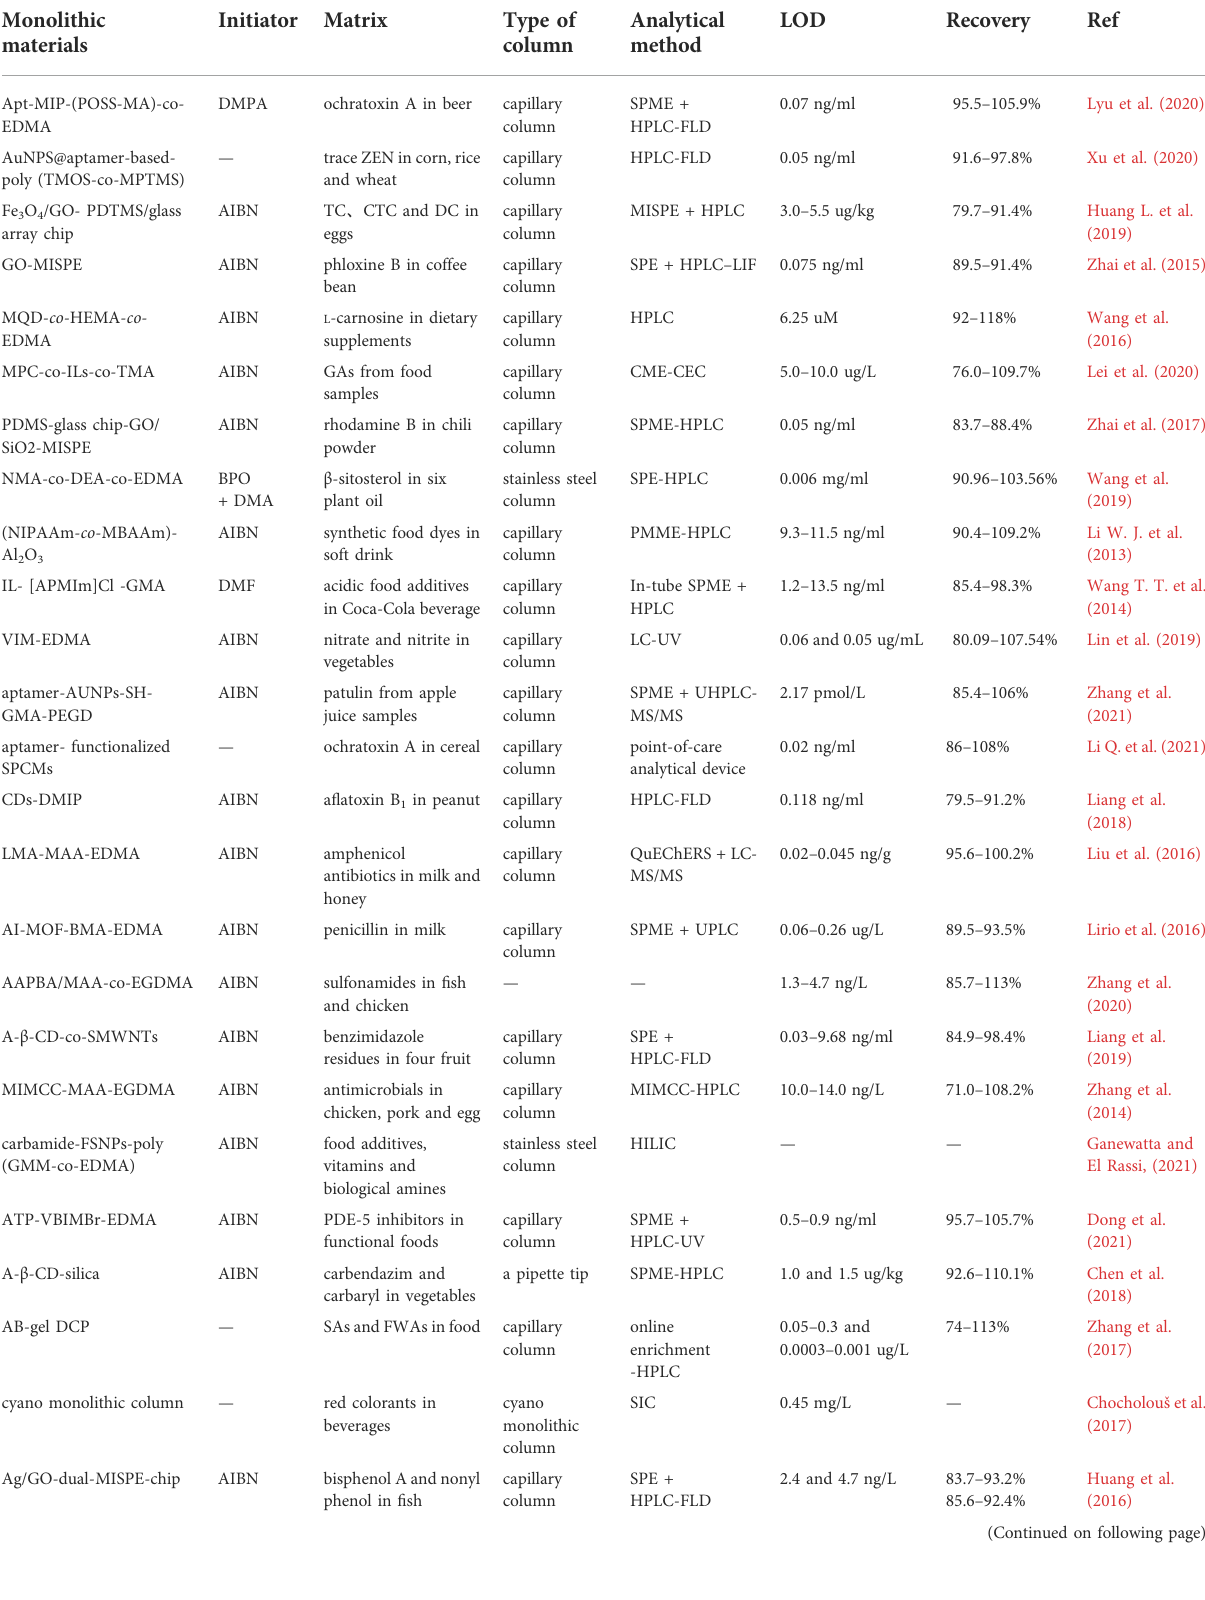
TABLE 2 Application of polymer monolithic columns in